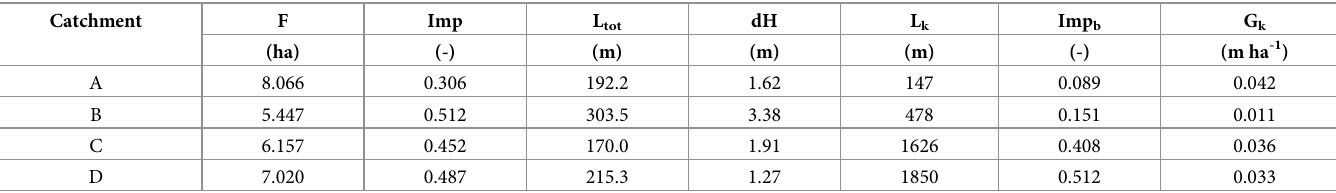
Table 1. Physical and geographic characteristics of the A, B, C, and D catchments.